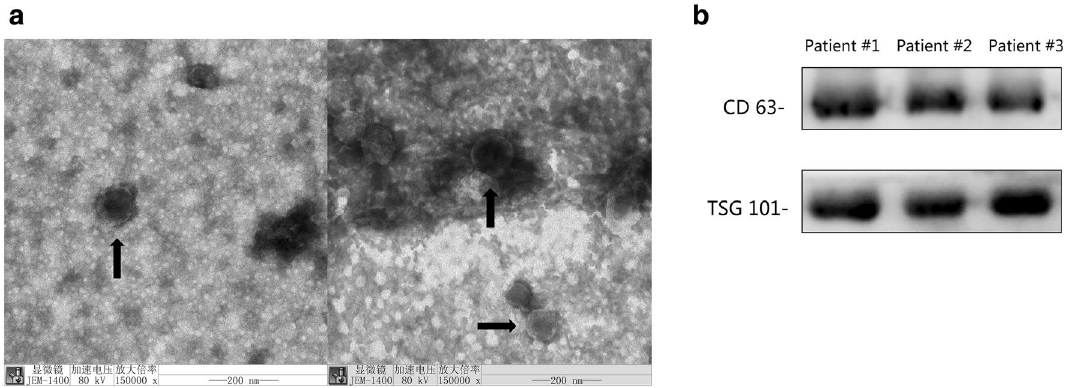
Figure 1. ( a ) Electron micrographs and ( b ) WB results of serum